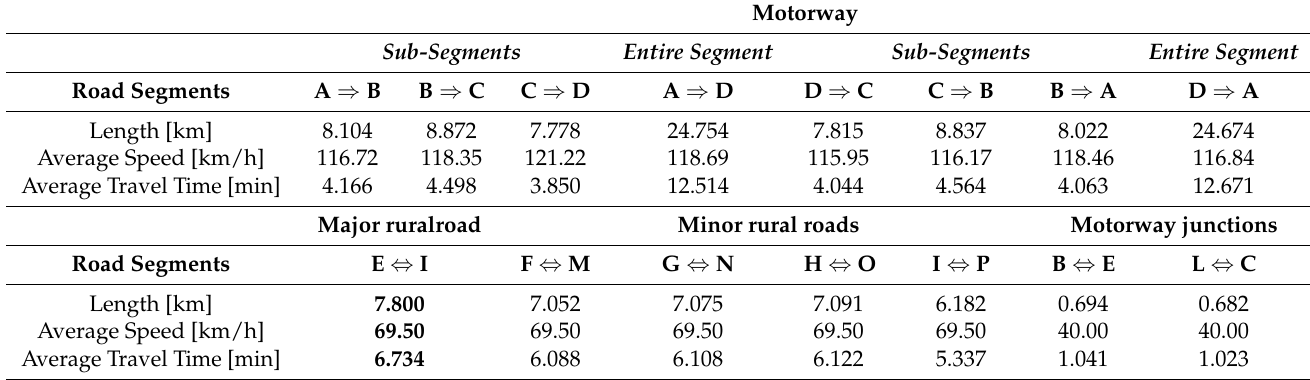
Table 3. Simulation results: average speed, and average travel time in ordinary functionality of the north tube without any disruptive event (i.e., Scenario 0). The first part of Table 3 reports the results related to the road segments characterized by unidirectional traffic (i.e., those of the motorway); whereas the second part of Table 3 refers to the road segments interested by bi-directional traffic (e.g., the major and minor rural roads) and motorway